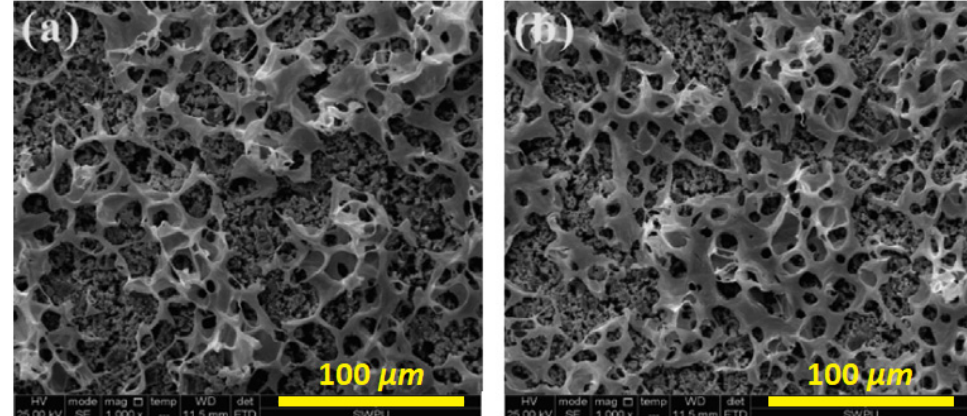
Figure 19. SEM images of the polyanionic cellulose-reinforced cement, with different degrees of hydration: ( a ) smaller; and ( b ) larger. Reprinted with permission from [169]. Copyright 2020, Elsevier.